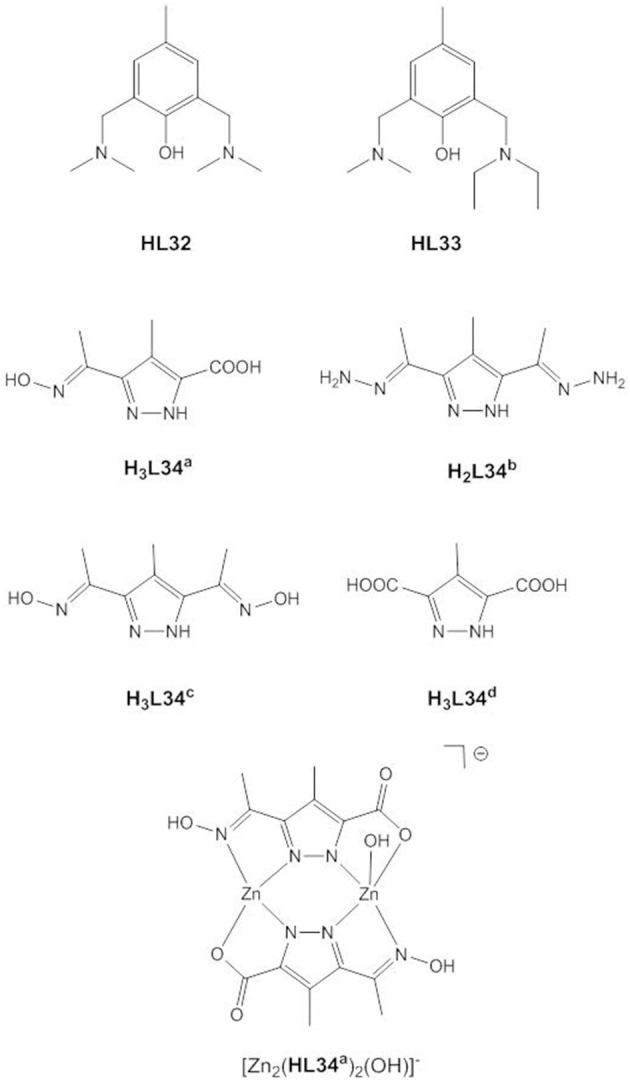
Chemical structures of ligands HL32 - H2L34 and [Zn2(HL34a)2(OH)]−.